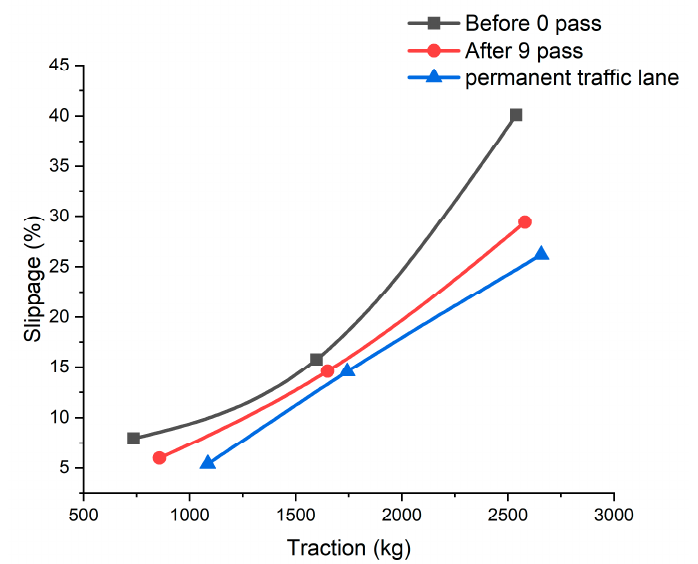
Figure 17. Slippage rate in different traffic conditions.